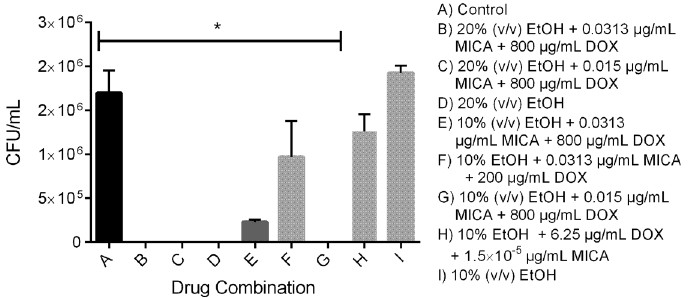
Fig 4. Mature C . albicans biofilm regrowth after 24 hour drug challenge. Combination solutions did not prevent the regrowth of mature biofilms on silicone. Following 24 hour drug challenge, biofilms were sonicated and incubated at 30°C for an additional 24 hours then plated solid media to quantify regrowth. Untreated and drug treated groups were compared using two-way ANOVA followed by Tukey post analysis. * indicates p value of <